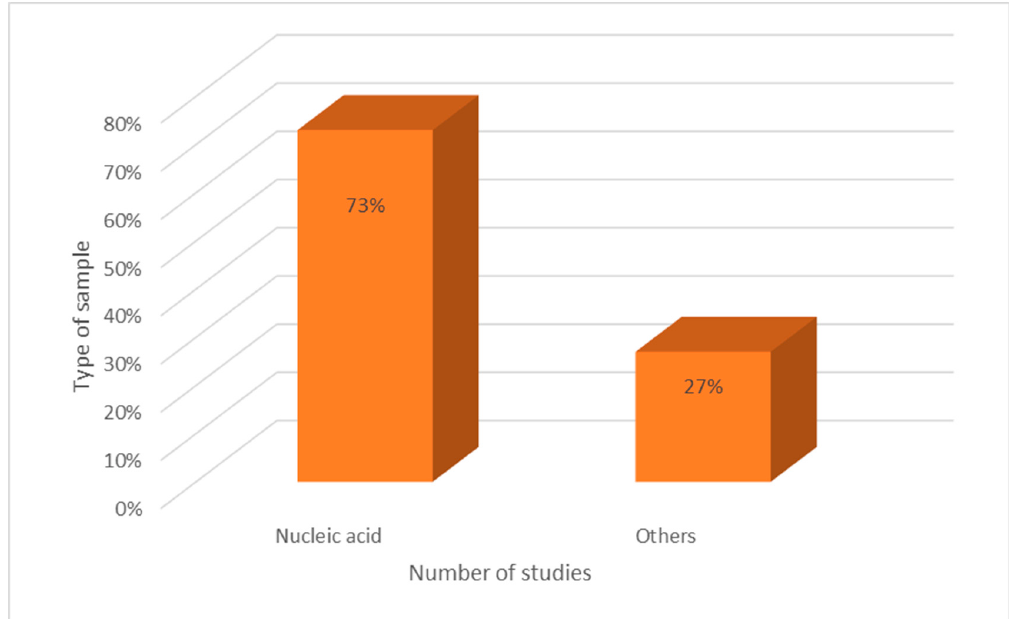
Figure 4. Types of samples used in nucleic-acid-based colorimetric detection.